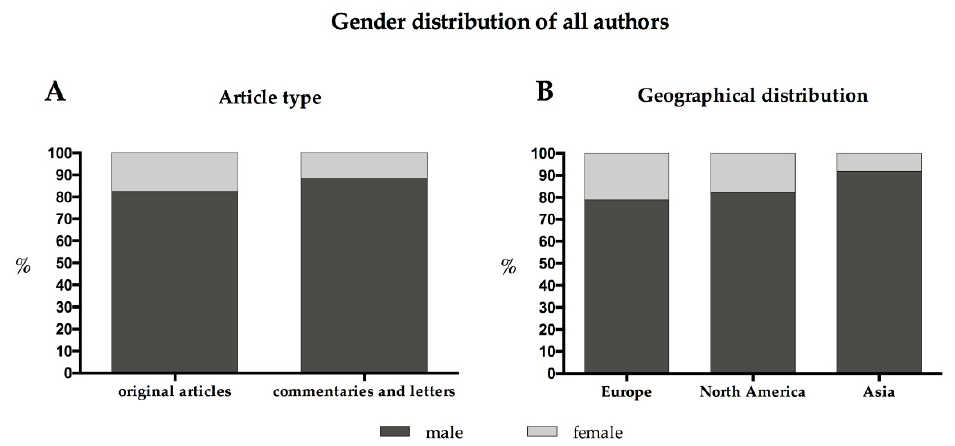
Figure 1. Gender distribution of all authors: ( A ) by article type and ( B ) by geographical distribution. In 15.7% ( n = 79), a female first author was found, whereas a female last author was seen in 9.5% (n = 48). Considering only women affiliated to a neurosurgical department, the numbers were reduced to 9.9% ( n = 50) and 6.8% ( n = 34) respectively. Related to the made up 12.8% of the neurosurgically affiliated first and 8.5% of the last authors (Figure